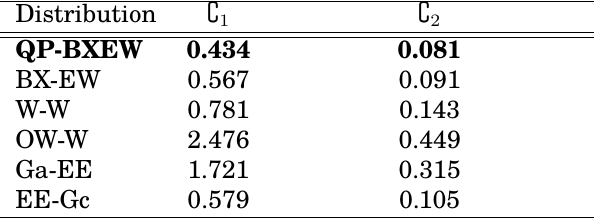
Table 7: (cid:123) 1 and (cid:123) 2 for the survival times data set. Distribution